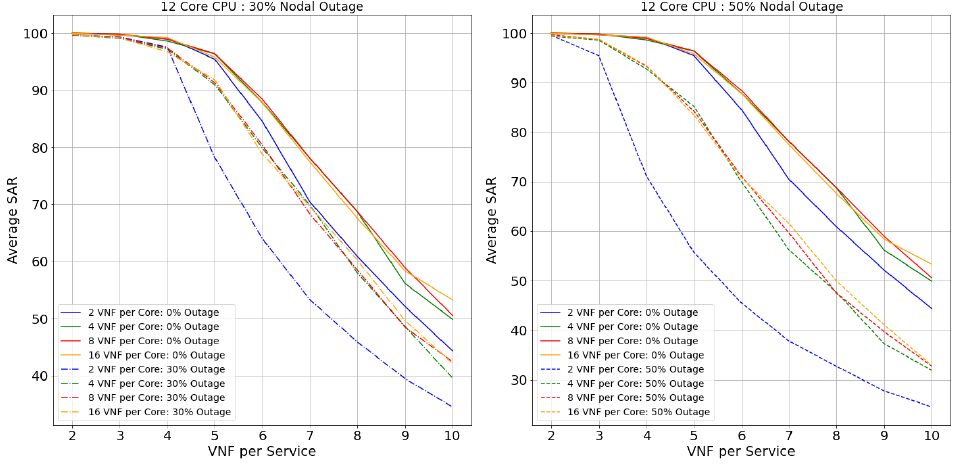
Figure 20. SAR: BtEurope topology with nodal outage—12 core